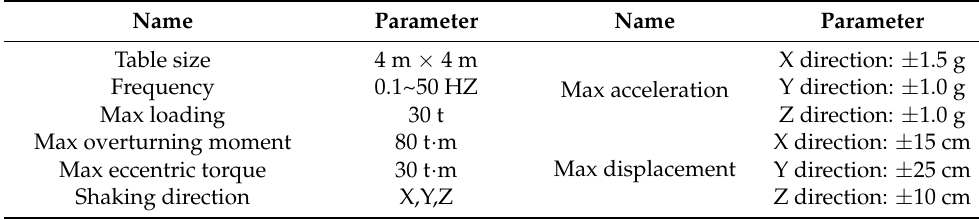
Figure 1. ( a ) Equipment and ( b ) control system of shaking table test. The white text on the red board is the project name in Chinese. Table 1. Specifications of the shaking table. Table 1. Specifications of the shaking